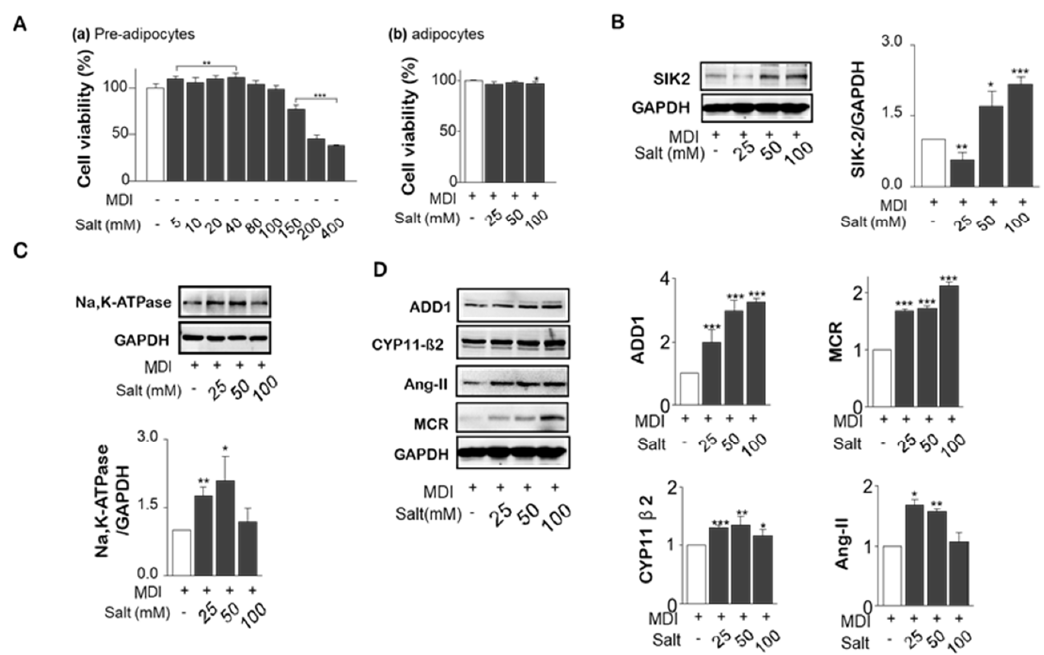
Figure 1. Effect of different levels of salts on cell viability, the expression of SIK2 and Na + /K + -APTase and insulin-related renin-angiotensin-aldosterone system (RAAS) signaling. 3T3-L1 preadipocytes were treated with various doses of salt (0 to 400 mM) during the differentiation period (from day 0 to day 7). Cell viability was measured by the CCK-8 kit in both of preadipocytes ( A - a ) and adipocytes ( A - b ). Protein expression of SIK2 ( B) and Na + /K + -ATPase ( C ) in salt-loading adipocytes were measured by western blotting. The major metabolites of RAAS, ADD1, CYP11 β 2, Ang II, and mineralocorticoid receptor (MCR), were analyzed by western blotting ( D ). Data are expressed as mean ± SE of three independent experiments or more. * p < 0.05, ** p < 0.01, *** p < 0.001, significant difference vs